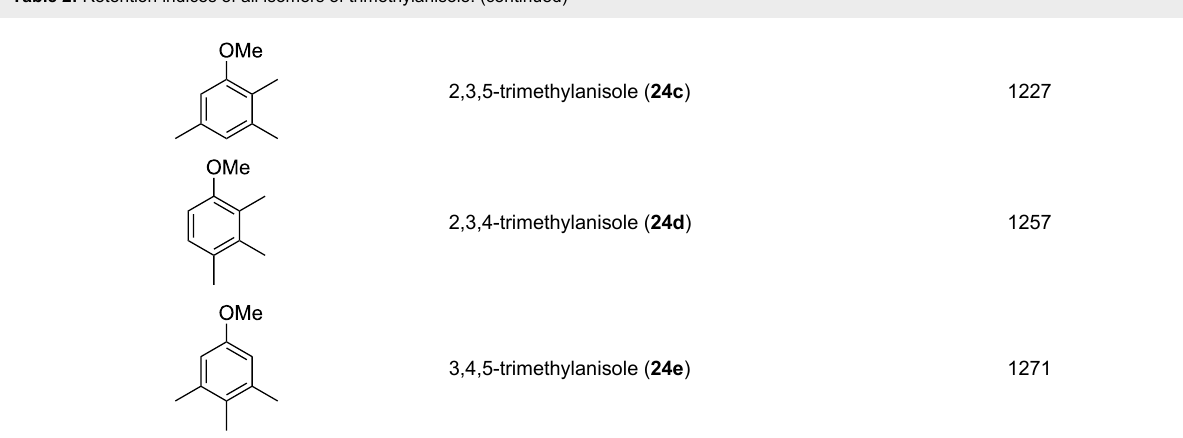
Table 2: Retention indices of all isomers of trimethylanisole.